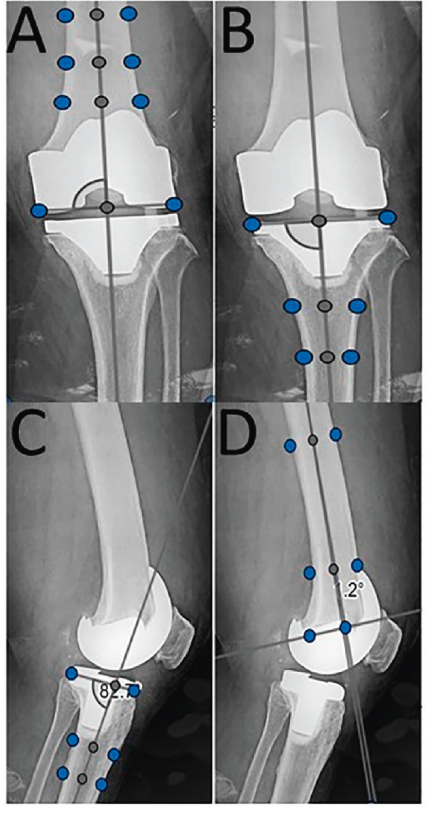
Figure 1: Radiographic outcomes. (a) Alpha ( α ) angle; (b) beta ( β ) angle; (c) delta ( δ ) angle; (d) gamma ( c )